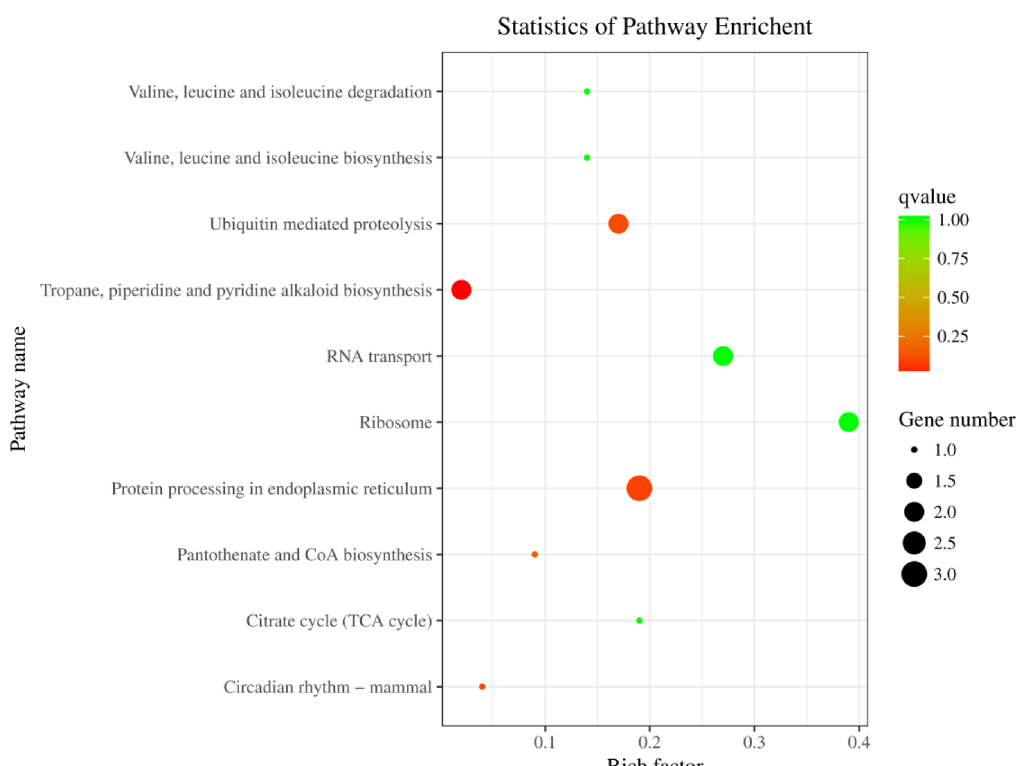
Fig 5. KEGG analysis of differentially expressed circRNA’s host genes.